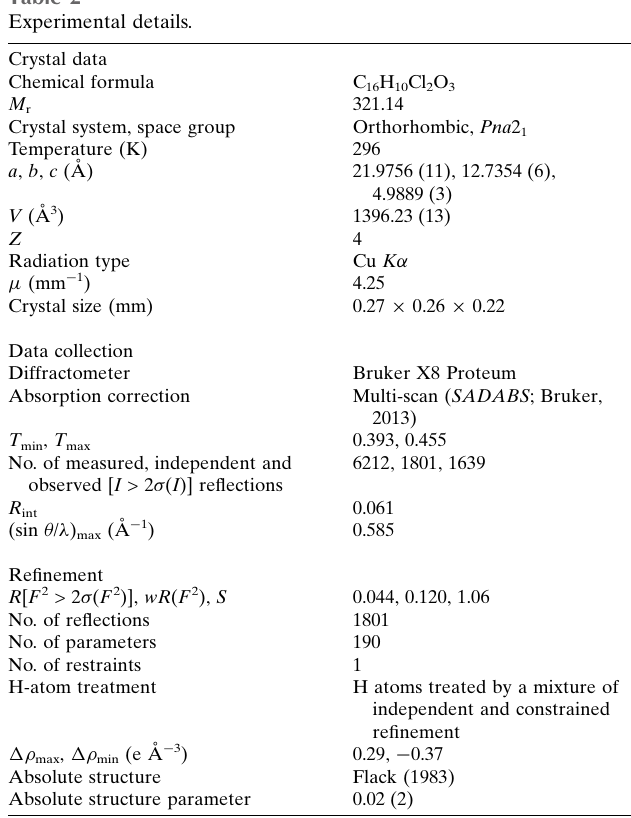
Table 2 Experimental details. Figure 1